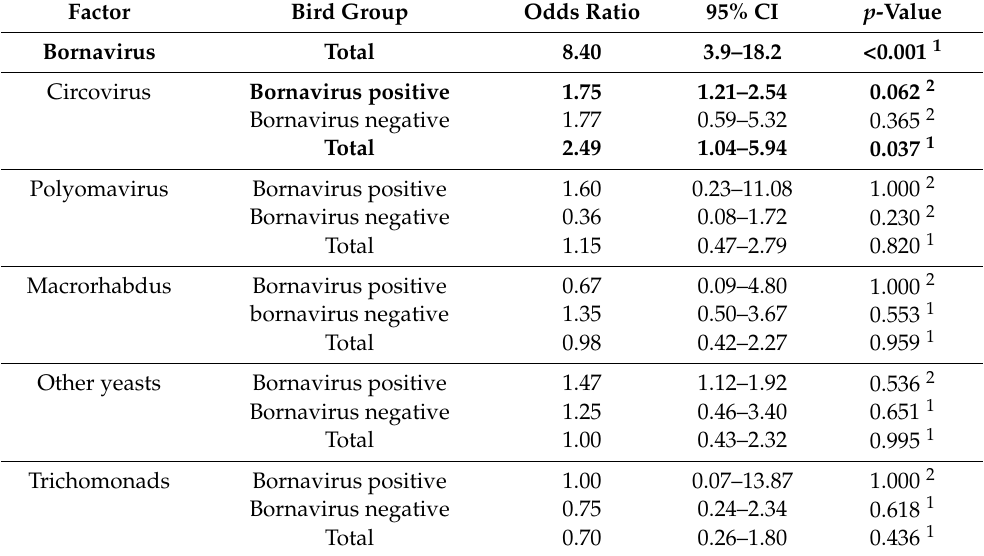
Table 4. Univariate (chi-square) analysis of factors potentially associated with the occurrence of PDD-like signs. Significant results are shown in